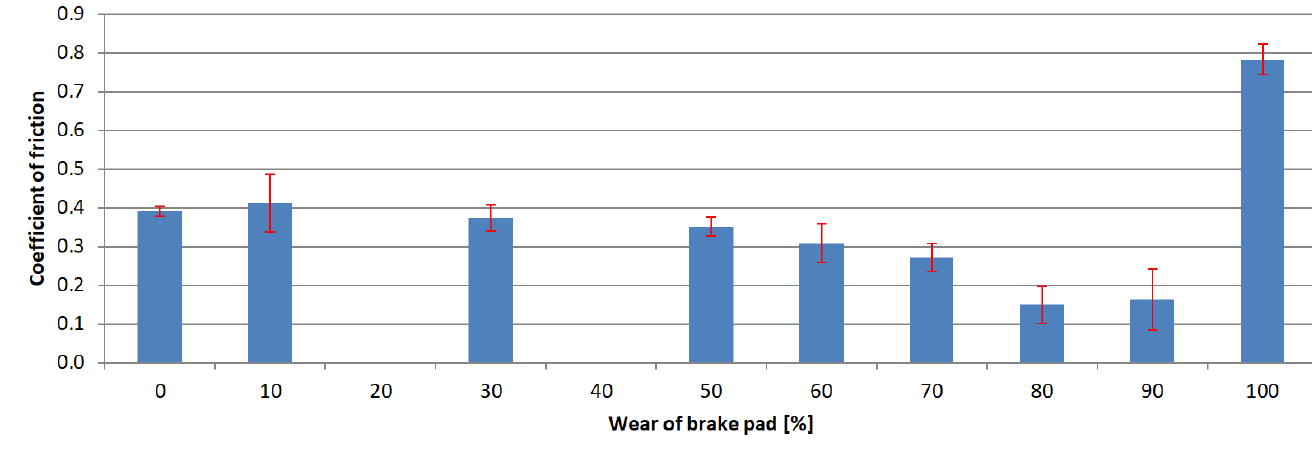
Figure 6. Coefficient of friction values of samples obtained from 1st brake pad group.